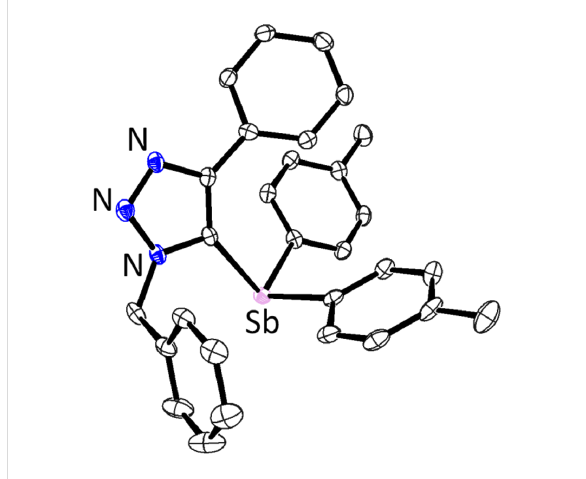
Figure 1: Ortep drawing of 3a with 50% probability. All hydrogen atoms are omitted for clarity. Two independent molecules exist in the asymmetric unit, one of them is